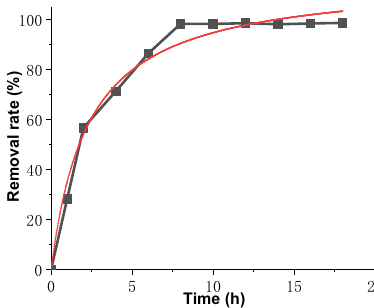
Figure 13. Pseudo-second-order models with linear Figure 13. Pseudo ‐ second ‐ order models with linear fitting. Figure 13. Pseudo ‐ second ‐ order models with linear fitting.